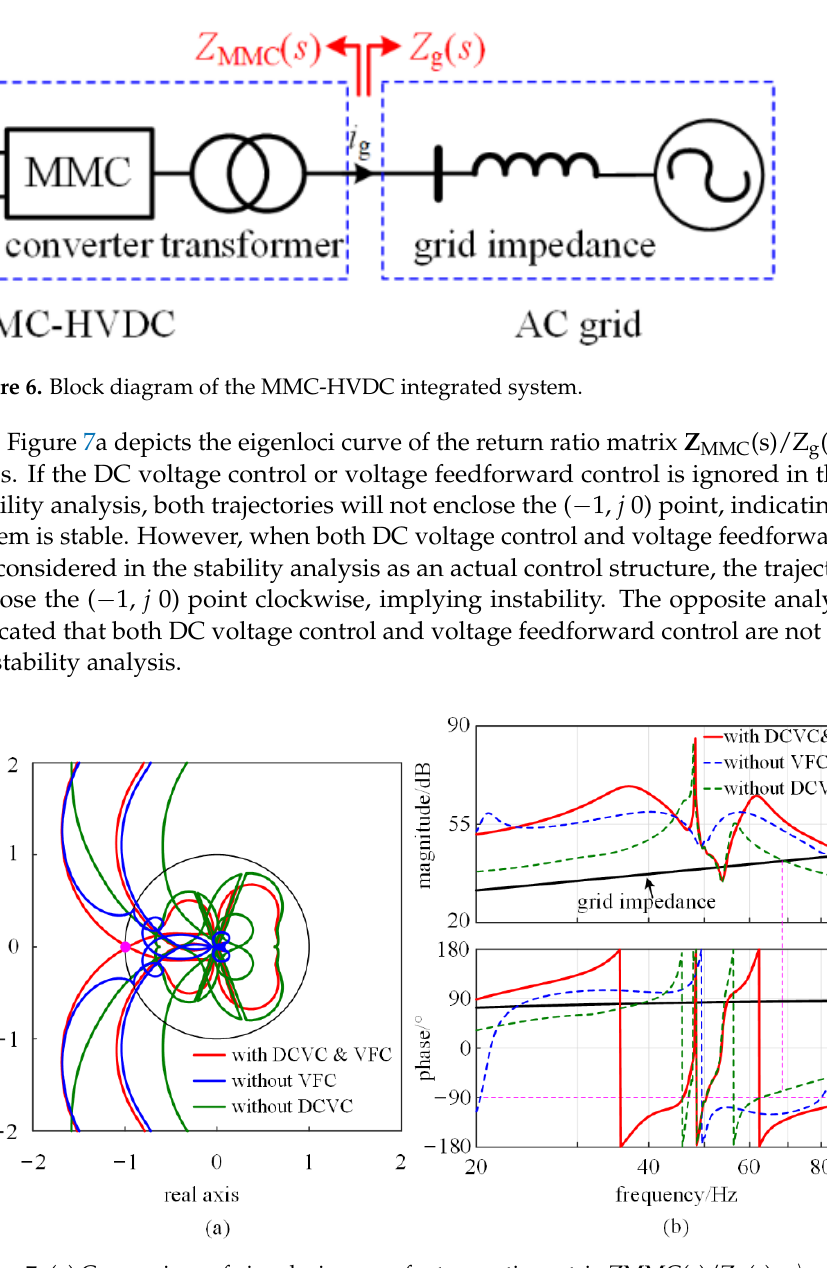
Figure 7. ( a ) Comparison of eigenloci curve of return ratio matrix ZMMC(s)/Zg(s) w\o DCVC and VFC; ( b ) Impedance responses of Z g ( s ) and Z MMC ( s ) w\o DCVC and